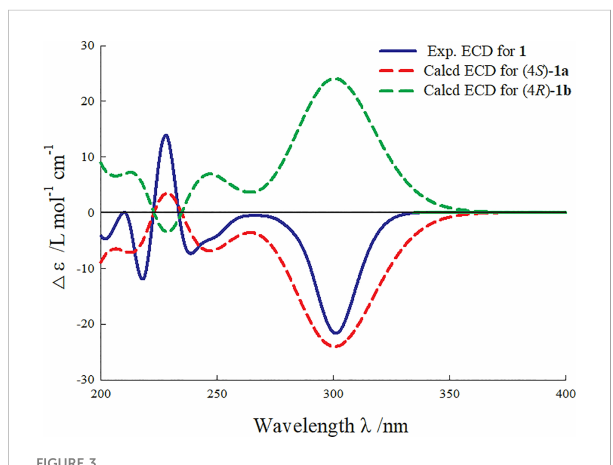
FIGURE 3 Experimental and calculated ECD curve of compound 1.